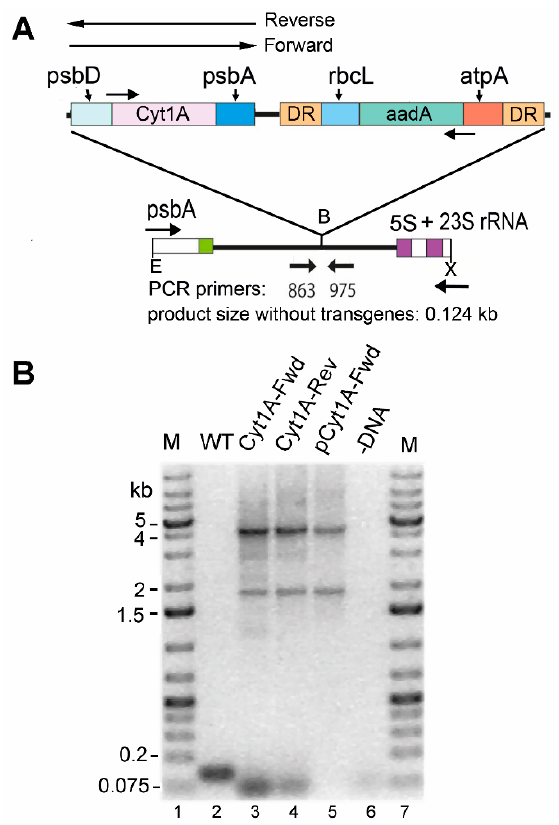
Figure 4. Introduced DNAs and analysis of homoplasmic cyt1Aa /CC-1690 transformants. ( A ) Diagram of the DNAs transformed into the chloroplast and the targeted region in the host, CC-1690 (WT). The arrows above the map indicate that the psbD m : cyt1Aa : psbA gene was cloned separately in both orientations, Reverse and Forward. The selectable marker gene, atpA : aadA : rbcL , which was only in the Reverse orientation, is flanked by 483-bp direct repeats (DR). E and X are restriction sites Eco RI and Xho I, respectively. ( B ) PCR analysis of homoplasmic transformants. PCR was performed with total DNA from the indicated strains (and plasmid) with primers (863 + 975) that flank the inserted DNA, to test for homoplasmicity. Lanes: M, DNA size markers; WT, CC-1690 host strain; Cyt1A-Fwd, transformant with psbD m : cyt1Aa : psbA in the Forward orientation; Cyt1A-Rev, transformant with psbD m : cyt1Aa : psbA in the Reverse orientation; pCyt1A-Fwd, plasmid that was transformed into CC-1690 to create the Cyt1A-Fwd transformant; -DNA, control reaction minus-DNA. Note: The ~1.8 kb band in lanes 3–5 is most likely a PCR artifact mediated by the large direct repeat (DR) at the ends of the selectable marker, which causes a deletion of the sequence between the DRs plus one copy of the DR, or ~2.5 kb.